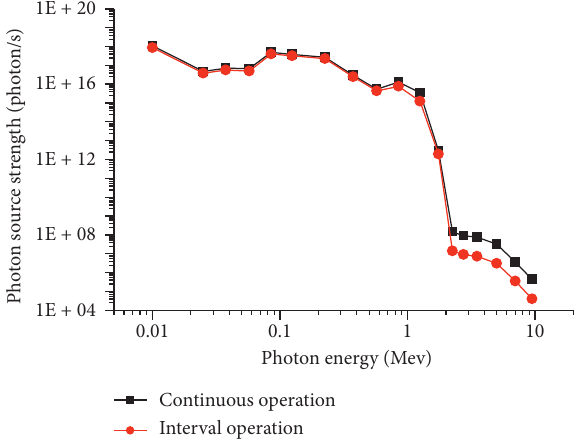
Figure 8: The photon source strengths under different operation modes. Table 3: The orthogonal table of fuel consumption, specific power, and enrichment.